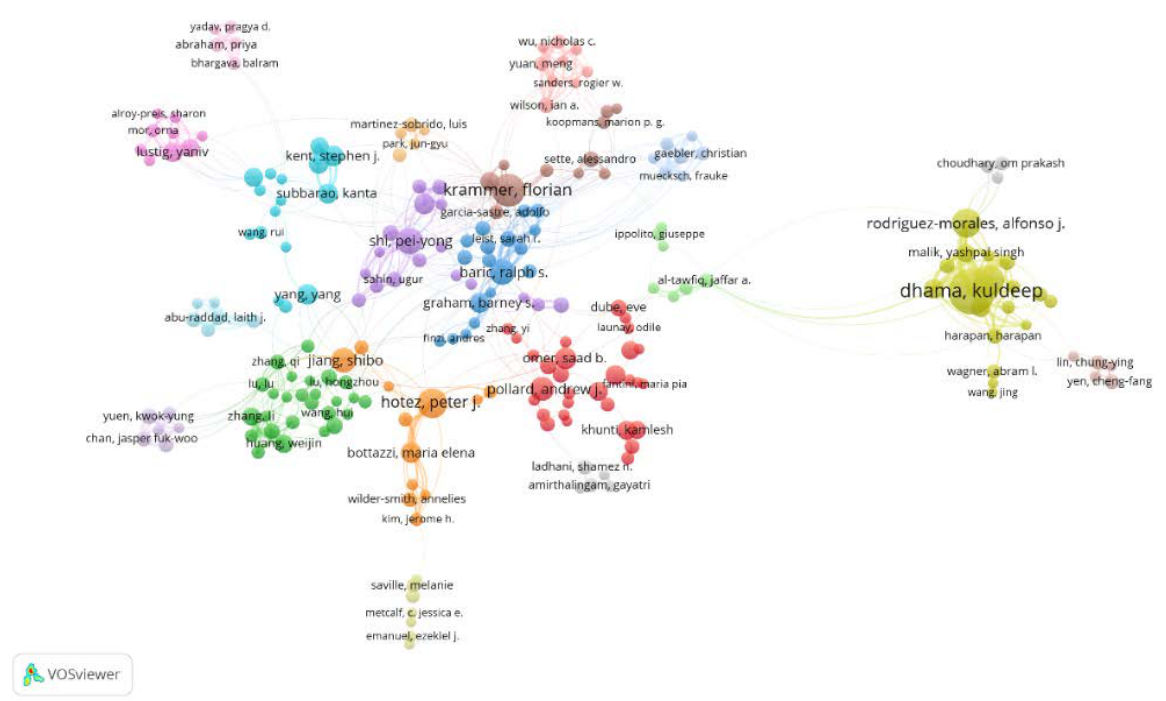
Figure 5. The cooperation chart for the authors, using network visualization through VOSviewer. To sum up, the results illustrated that copious authors made contributions on this field, and the prominent authors did not have too many